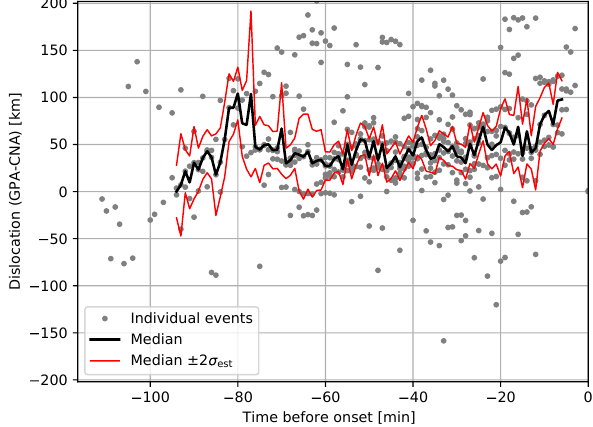
Figure 5. Dislocation of the brightest part of the growth-phase arc with respect to the CNA maximum for all 10 events. Data are aligned to the moment of onset (right-hand